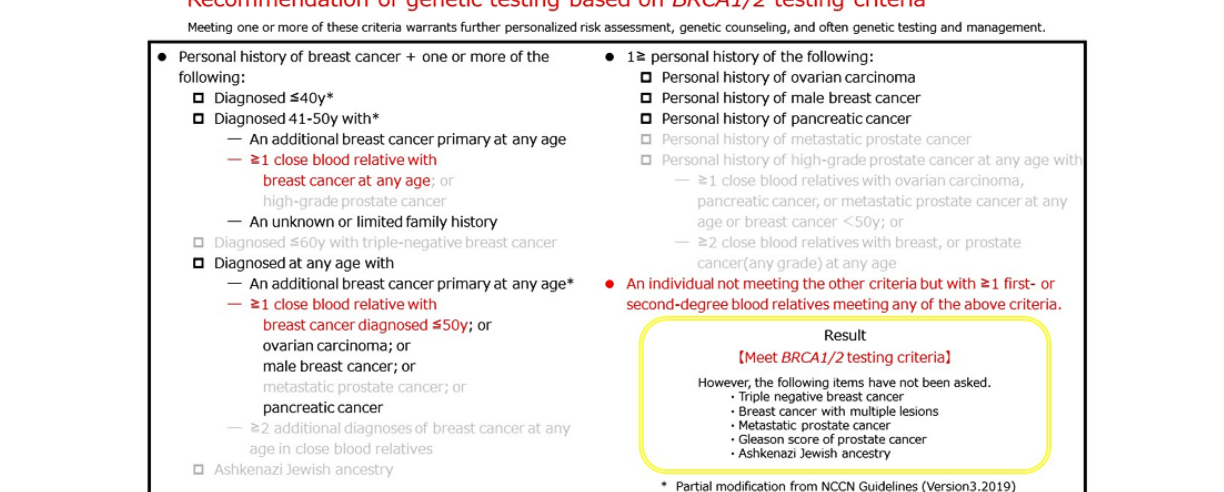
Figure 6. Snapshot of the results of a preliminary screening by the chatbot for scenario 1, according to the criteria of the National Comprehensive Cancer Network (NCCN). We have partially modified the criteria according to our clinical practice at the Kanagawa Cancer Center. The results were originally presented in Japanese and translated into English. Black font: unmet items; red font: met items; gray font: items that had not been asked by this system; yellow square: the final result; “close blood relative:” includes first-, second-, and third-degree